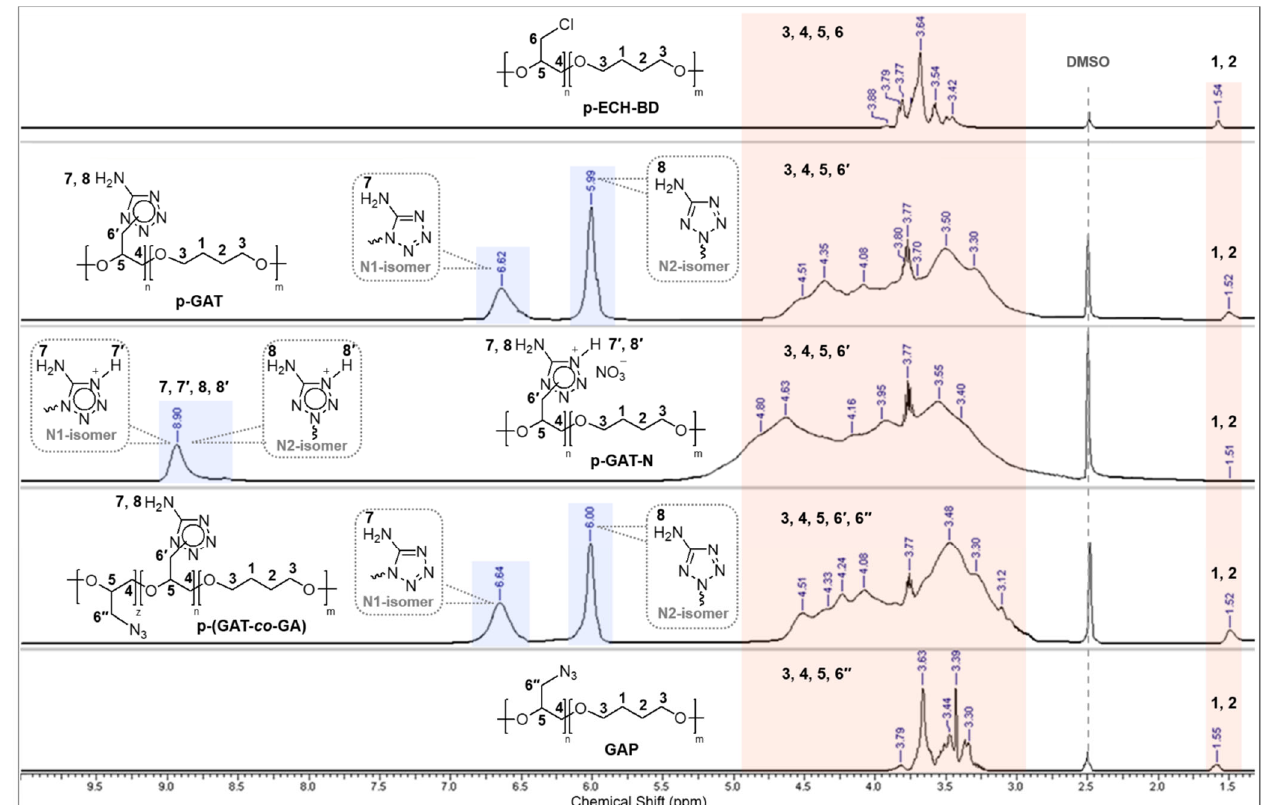
Figure 3. 1 H NMR spectra of p ‐ ECH ‐ BD, p ‐ GAT, p ‐ GAT ‐ N, p ‐ (GAT ‐ co ‐ GA) and GAP polymers.